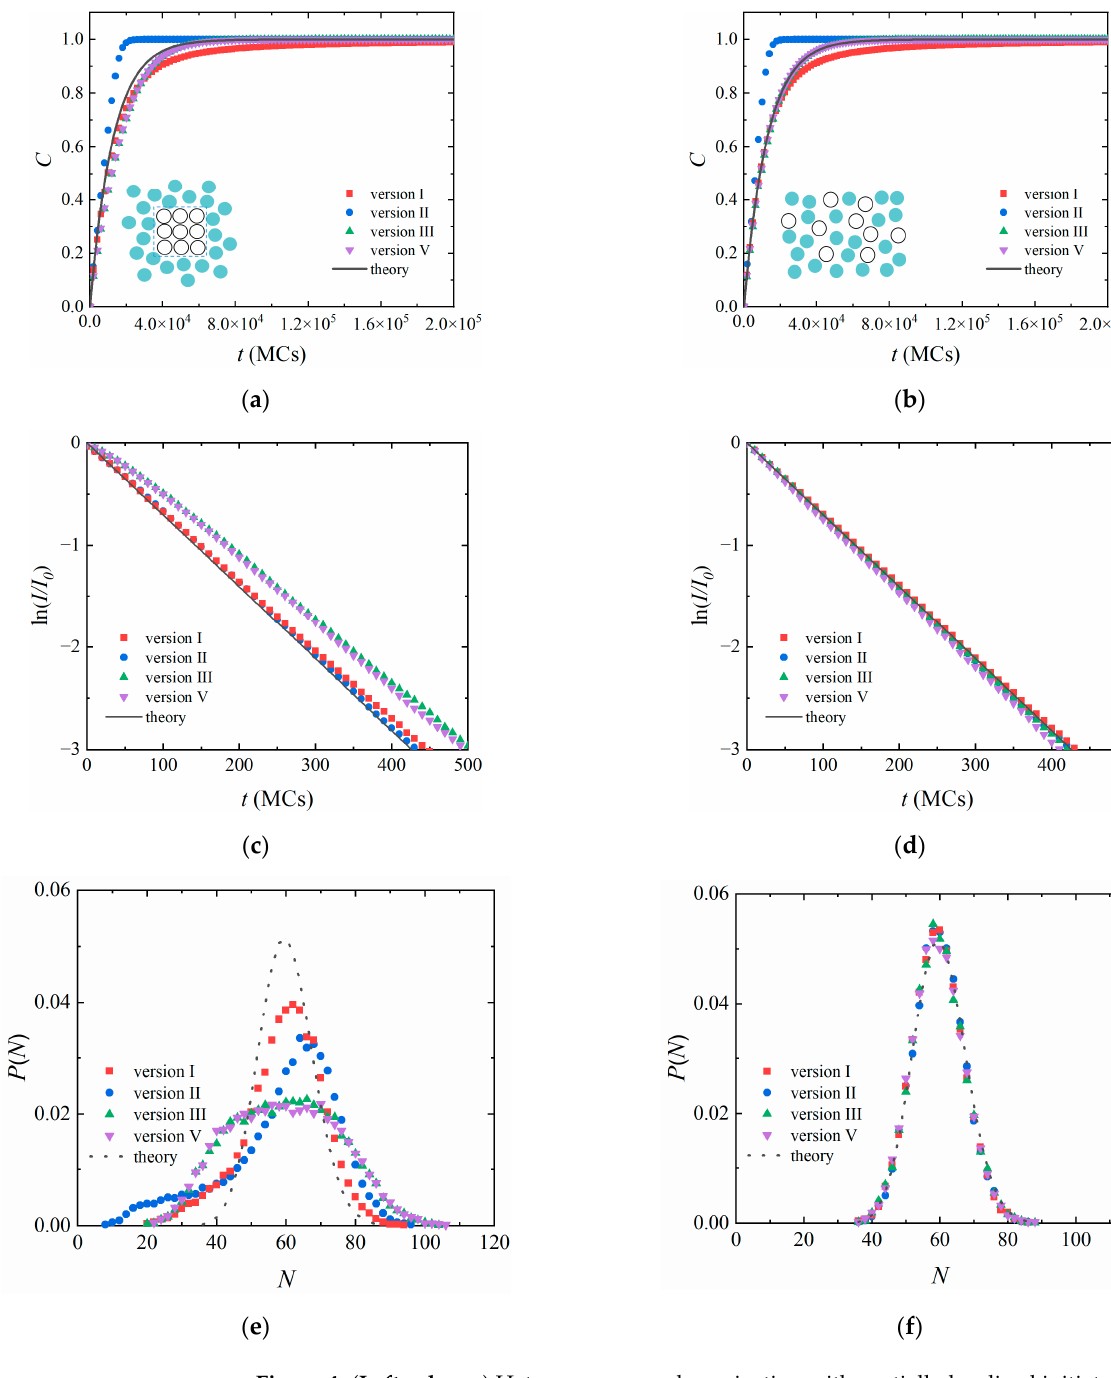
Figure 4. ( Left column ) Heterogeneous polymerization with spatially localized initiators; ( right col- umn ) homogeneous polymerization with randomly dispersed initiators. ( a , b ) Monomer conversion C . ( c , d ) the ratio of unreacted initiators I / I 0 . ( e , f ) molecular weight distribution with M n = 60. The dotted lines are Poisson distributions. The inlets are the 2D illustrations of the spatially localized and randomly distributed initiators, respectively. The cyan cycles: free monomers; hollow cycles: initiators. The number of initiators I 0 = 1000, the reaction interval time τ = 10 MCs, and the reaction probability between one active center and one monomer P 0 =